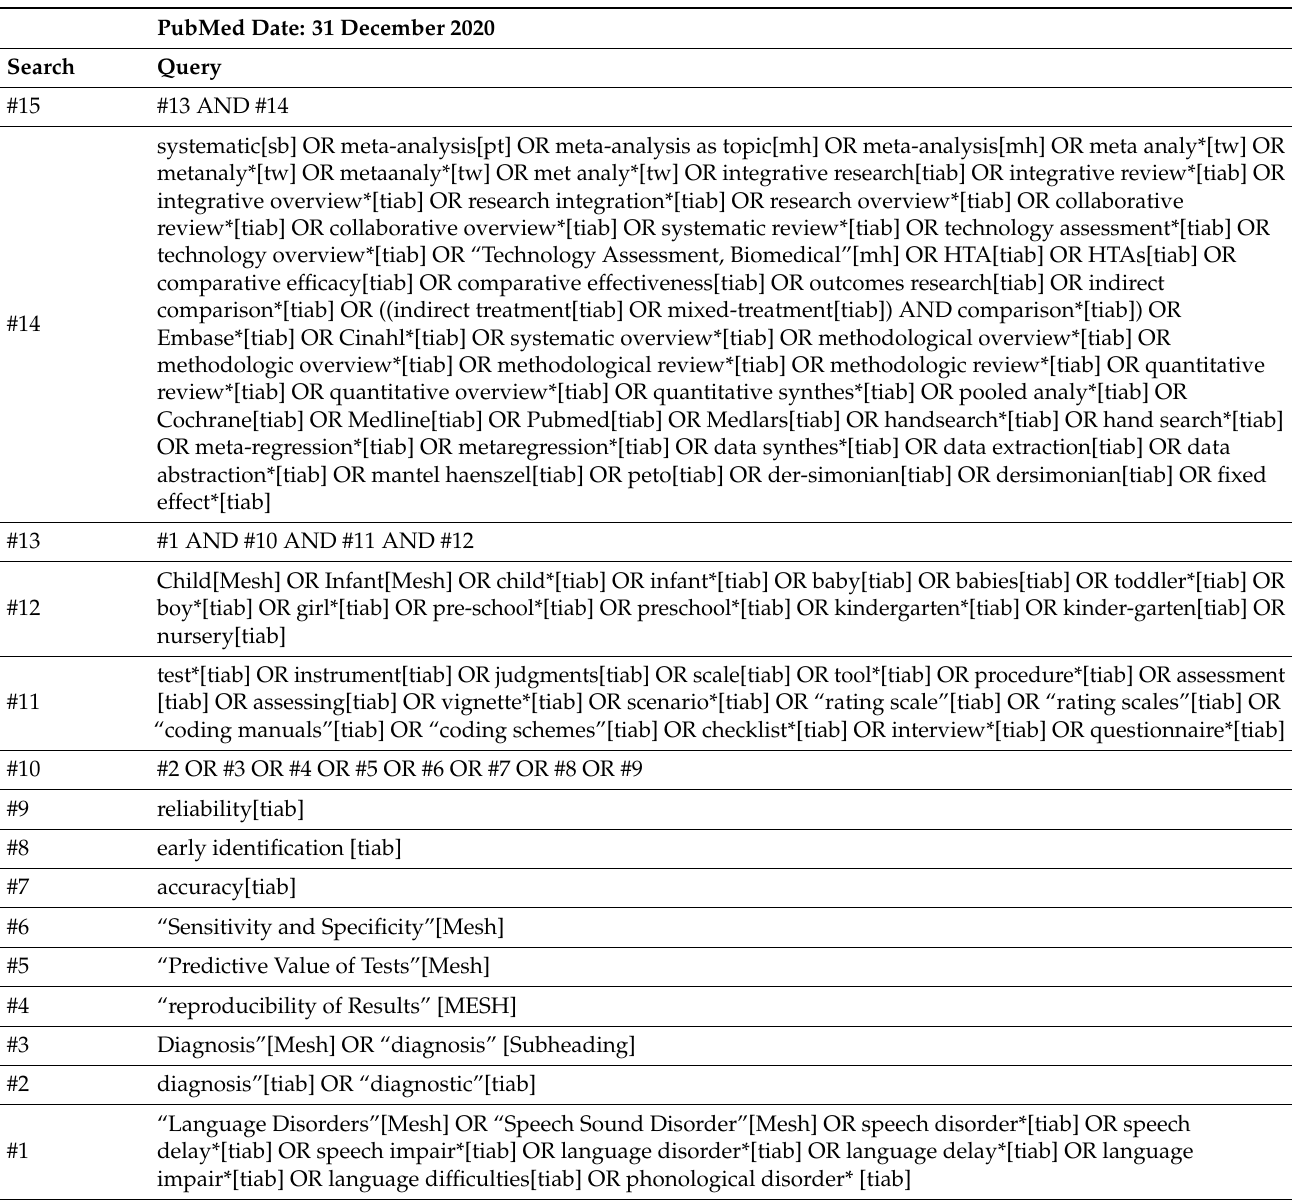
Table A1. Search strategy for